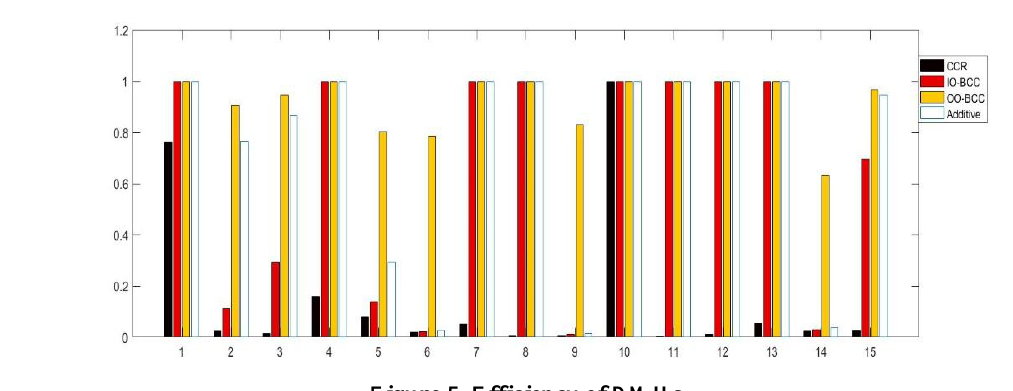
Figure 5. Efficiency of DMUs.